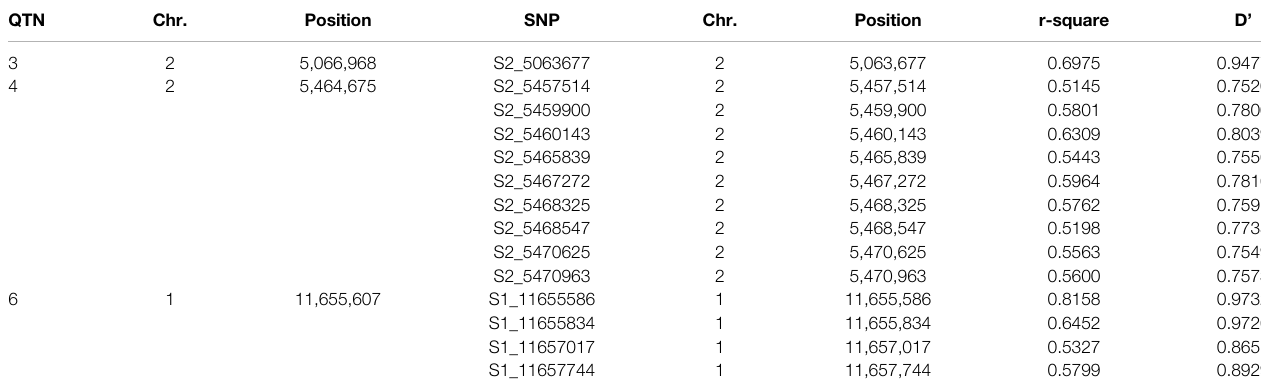
( Figure 1B ). And the area under the Power-Type I error curve demonstrated the similar trends ( Figures 1C,D ). Clearly, the power of ScoreEB is comparable to that of the other two multi- locus methods mrMLM and